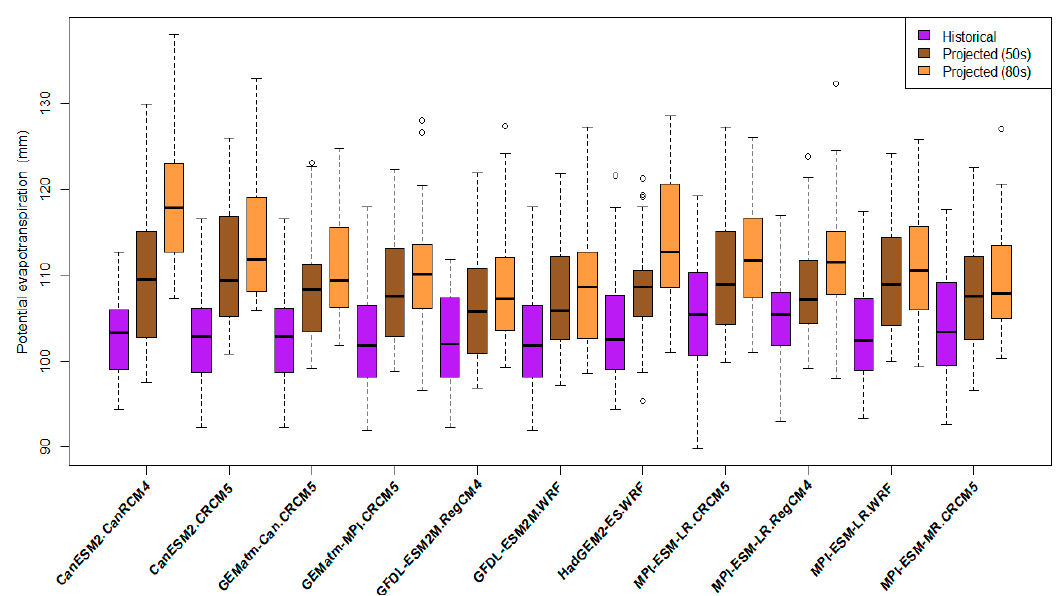
Figure 6. Temporally averaged PET in historical and projected changes.